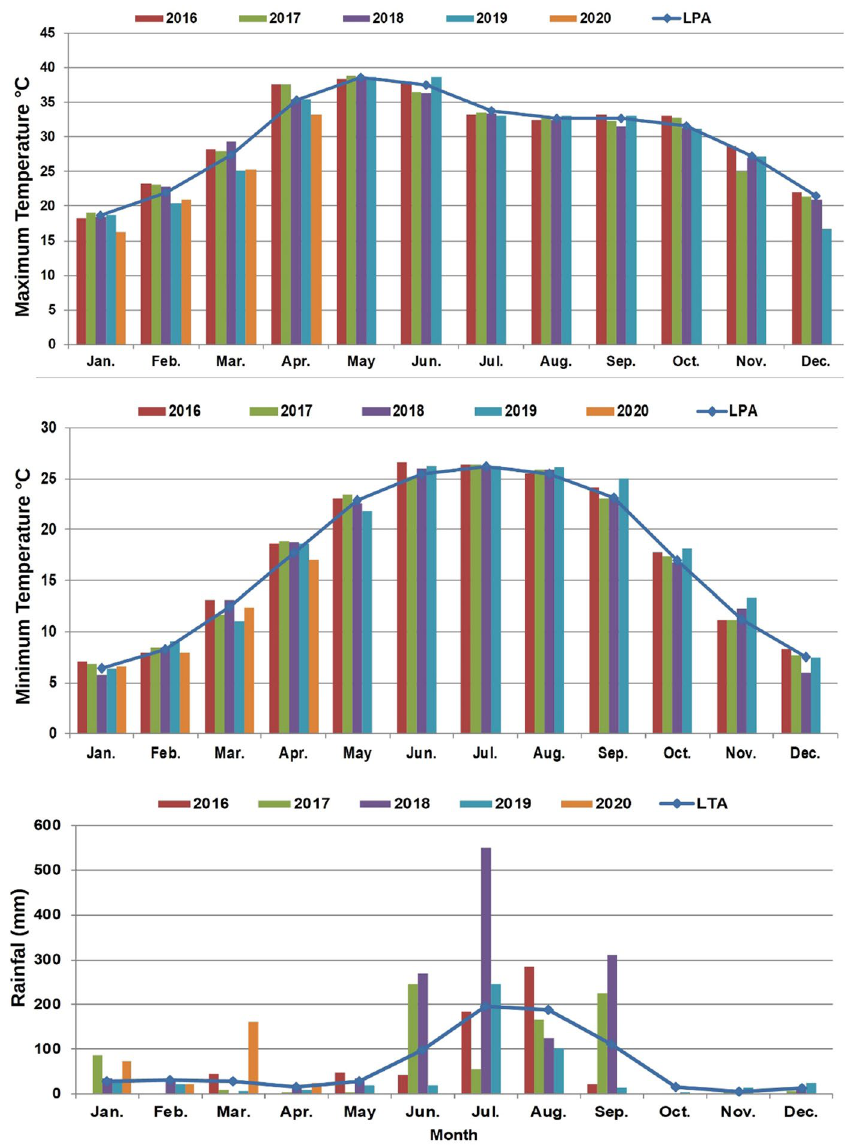
Figure 1. Maximum and minimum temperature and rainfall during the crop